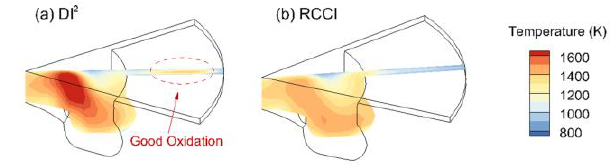
Fig. 15. Comparison of the in-cylinder temperature distribution between the representative cases of DI 2 and RCCI at CA50 (reproduced from [9])